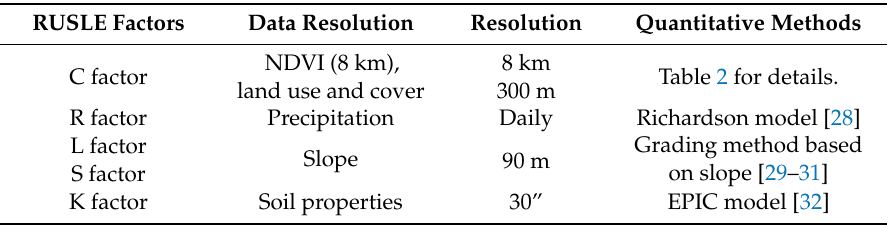
Table 1. Quantitative numbers on all Revised Universal Soil Loss Equation (RUSLE) factors.